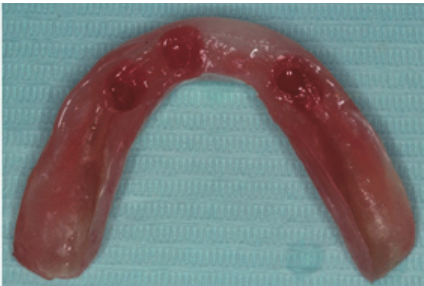
Figure 3: Alignment of the four implants’ position.